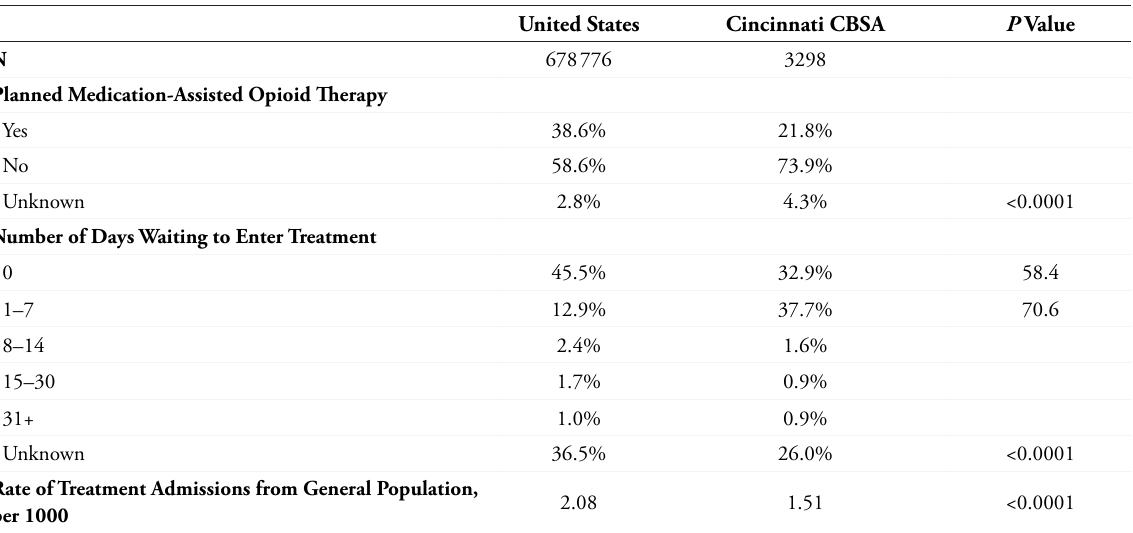
Table 2. Unadjusted Outcome Results by Cincinnati CBSA and the United